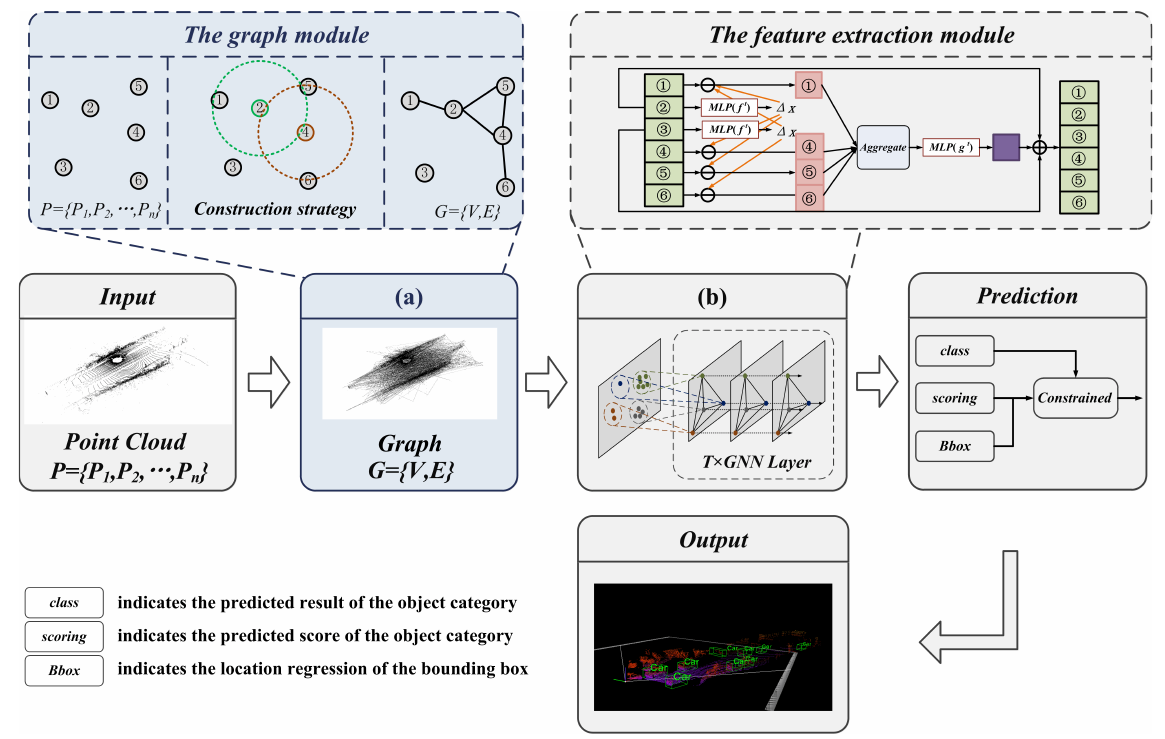
Figure 1. Framework